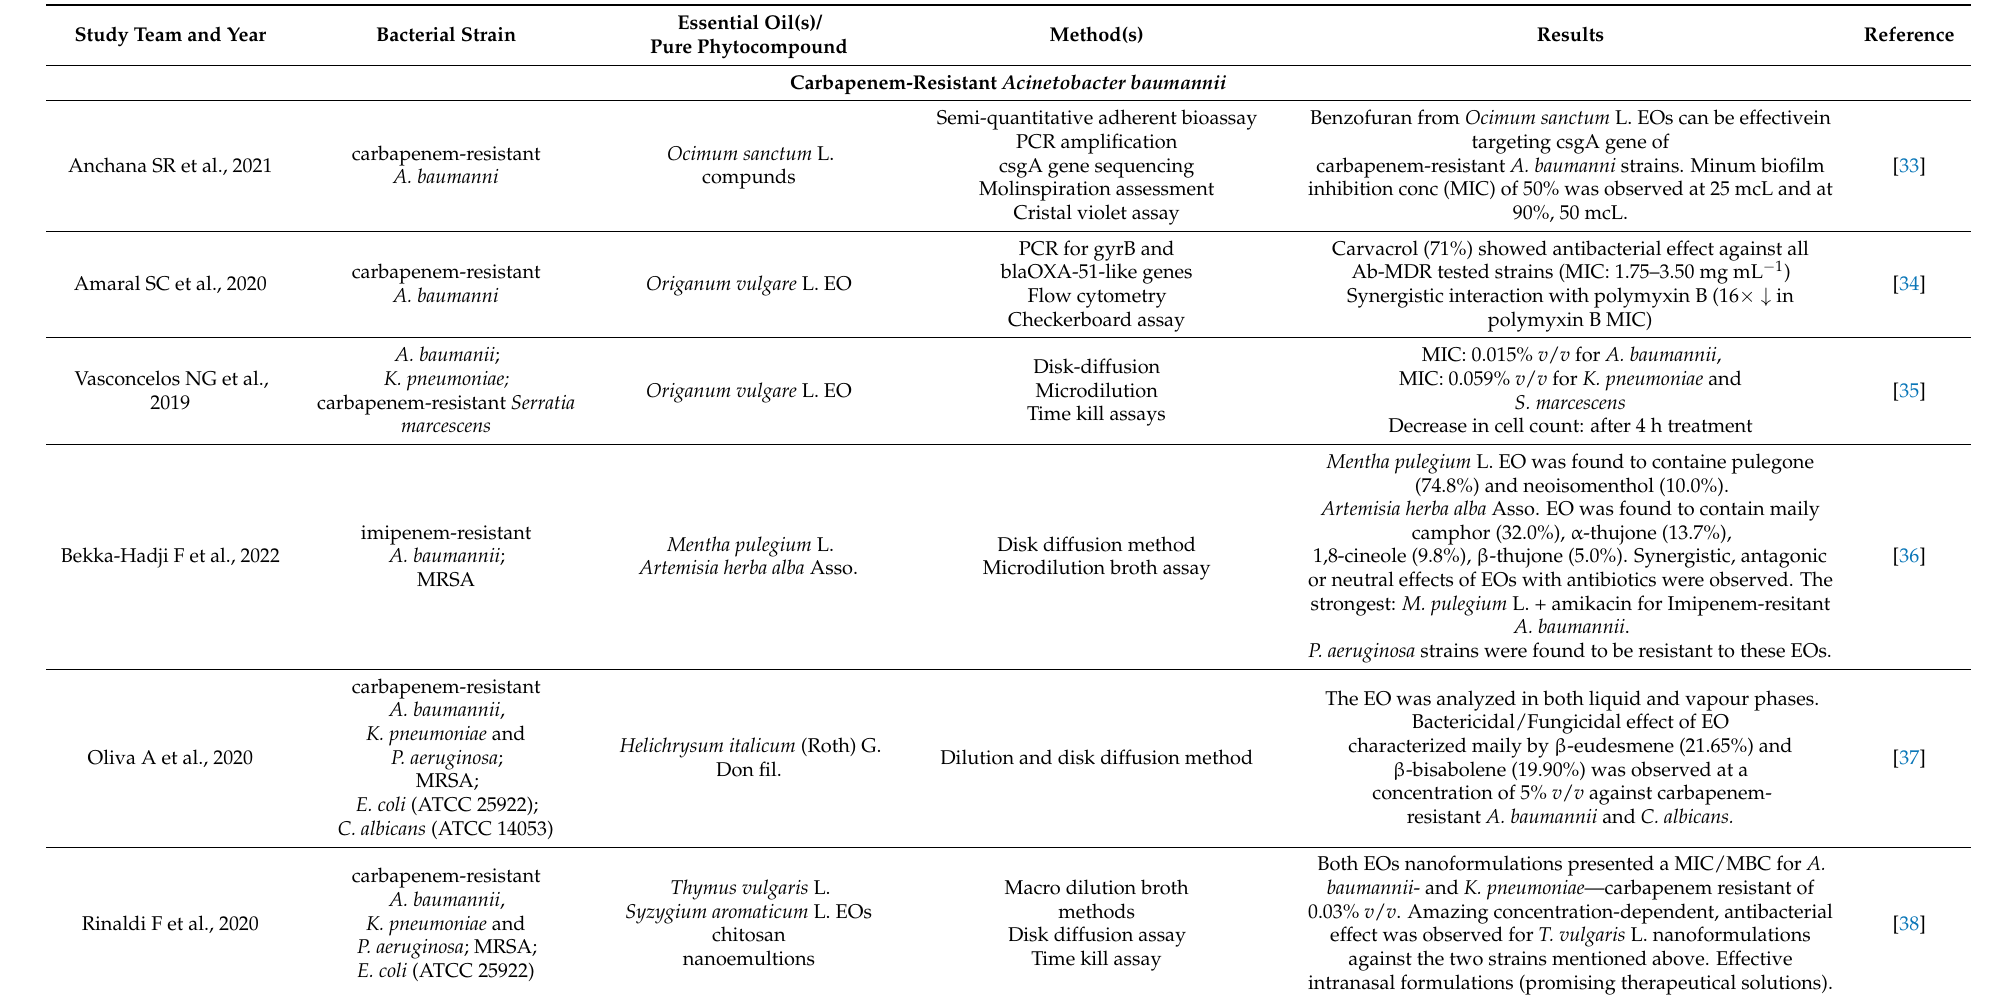
Table 3. The effects of different EOs on WHO critical priority